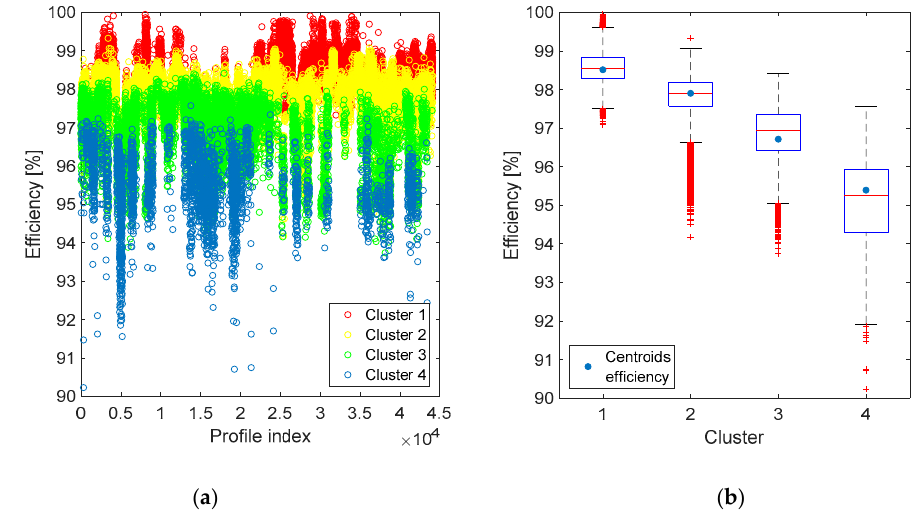
Figure 8. 2D clustering: efficiency of the different profiles grouped in clusters ( a ) and corresponding box plot ( b ).